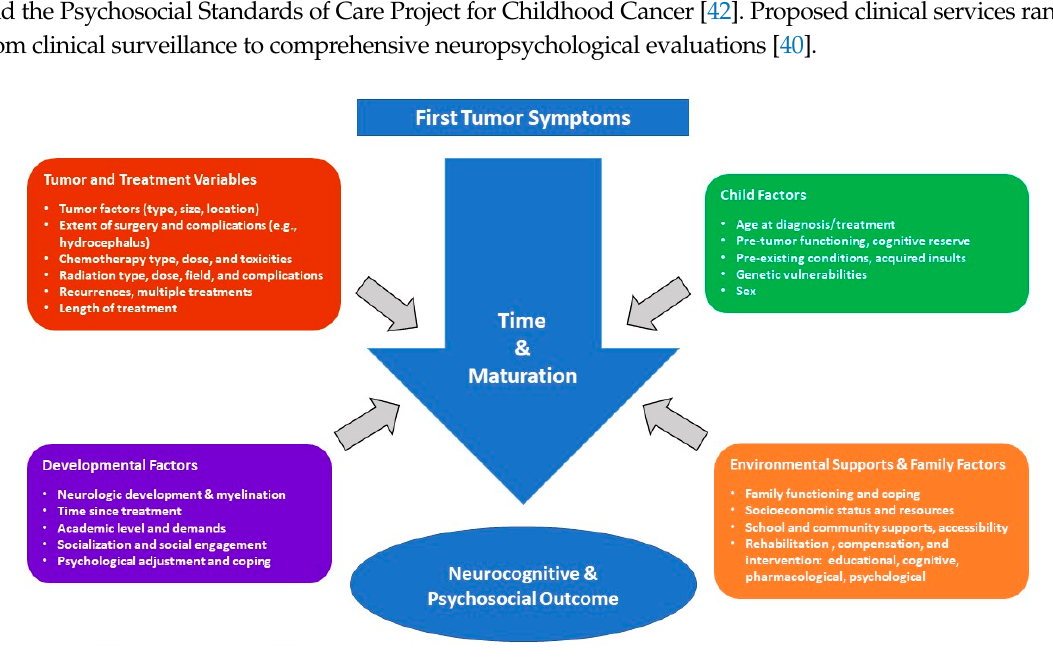
Figure 1. Factors affecting outcome in PBT survivors.